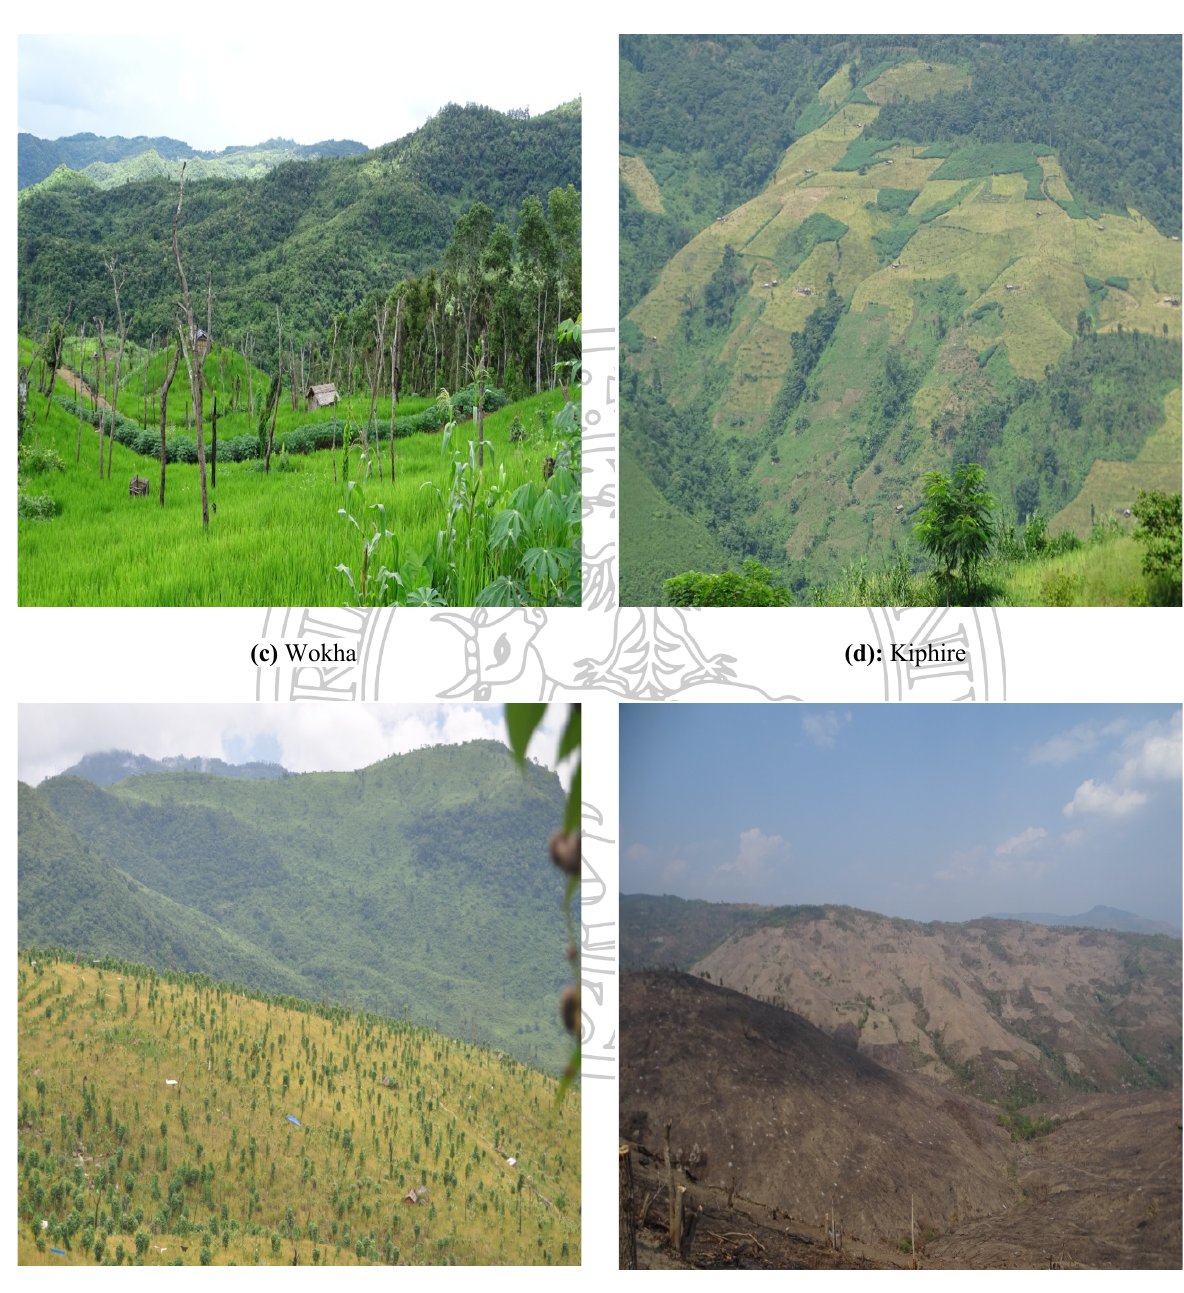
Figure 8 – Practice of Jhum cultivation in Nagaland (a): Mokokchung (b):